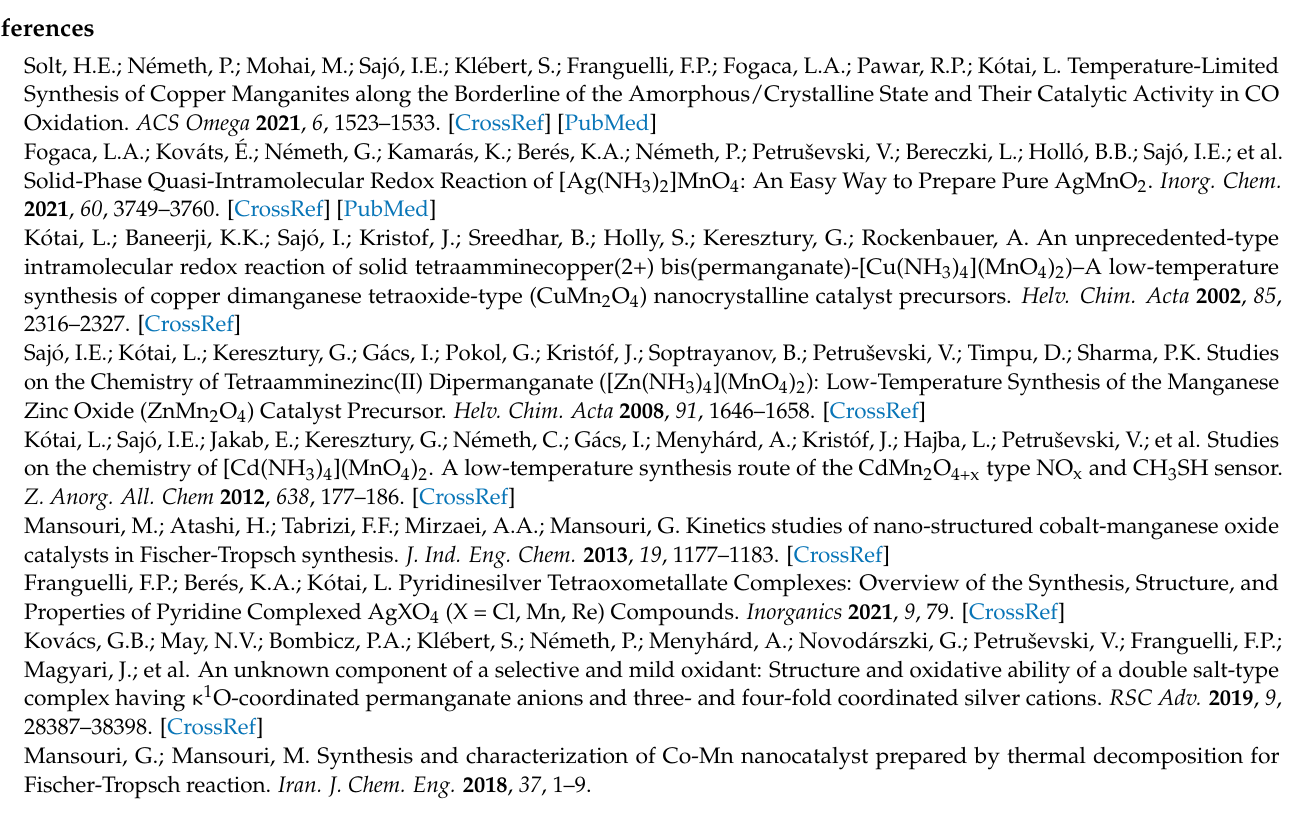
compound 3-Mn in the range of 400–100 cm − 1 at room temperature; Figure S6: Far-IR spectrum of the deuterated compound 3-Mn in the range of 400–100 cm − 1 at room temperature; Figure S7: IR spectrum of the deuterated compound 3-Mn in the range of 4000–400 cm − 1 at room tempera- ture; Figure S8: Raman spectra of the deuterated compound 3-Mn in the range of 1100–100 cm − 1 at 123 and 298 K; Figure S9: UV-VIS spectrum of compound 3-Mn ; Figure S10: TG-DTG-DTA curves of compound 3-Mn in argon (a) and air (b) atmosphere; Figure S11: Selected TG-MS curves of compound 3-Mn in air (a) ( m / z = 35, Cl + ; m / z = 30 (NO + ); m / z = 46, NO 2+ ; m / z = 18, H 2 O + ; m / z = 17 OH + , NH 3+ ) and argon (b) atmosphere ( m / z = 35, Cl + ; m / z = 30 (NO + ); m / z = 18, H 2 O + ; m / z = 17 OH + , NH 3+ ); Figure S12: Far-IR spectra of the thermal decomposition intermediates formed from compound 3-Mn in air (a) and inert (b) atmosphere; Figure S13: DSC analysis of compound 3-Mn in pure oxygen (a) and nitrogen (b); Table S1: Crystal data and structure refinement of compound 3-M ; Table S2: Bond lengths (Å) and angles ( ◦ ) in compound 3-Mn ; Table S3: Analysis of potential hydro- gen bonds and schemes with d(D . . . A) < R(D) + R(A) + 0.50, d(H . . . A) < R(H) + R(A) − 0.12